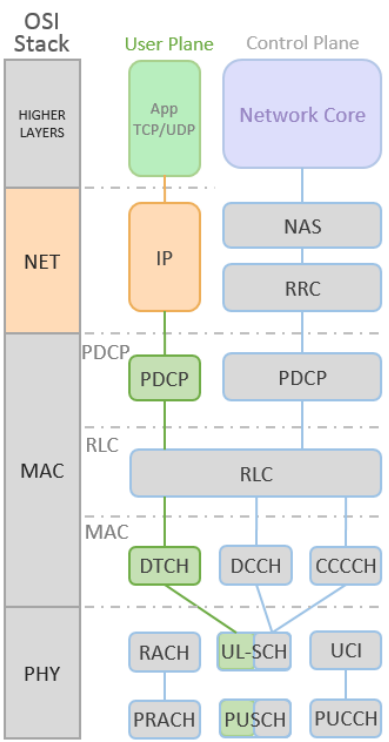
Figure 21. LTE eMTC uplink